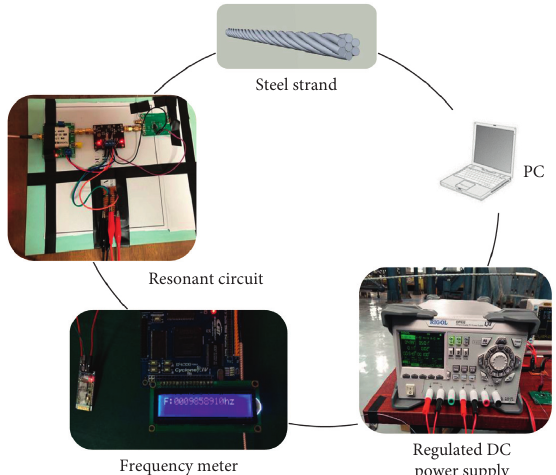
Figure 6: LC electromagnetic resonance detection system detection